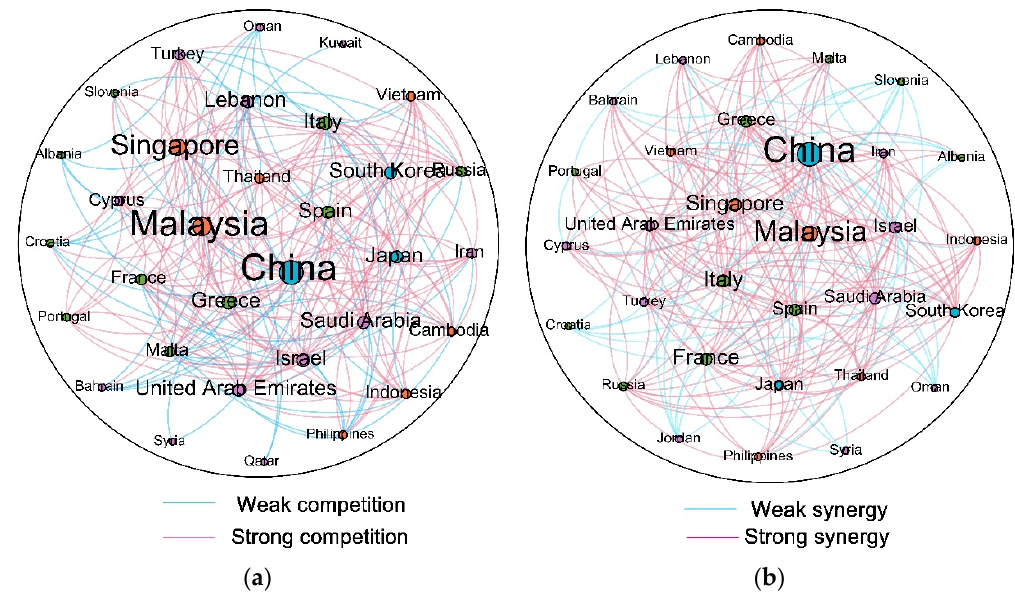
Figure 10. Significant traffic network between countries across regions: ( a ) Competition relations between countries across regions; ( b ) Synergy relations between countries across regions. The visualization is made by Gephi.